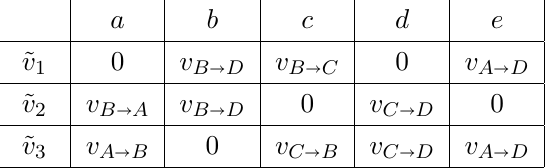
= v + v , where the two r.h.s. terms A A B A D (cid:1) (cid:1)